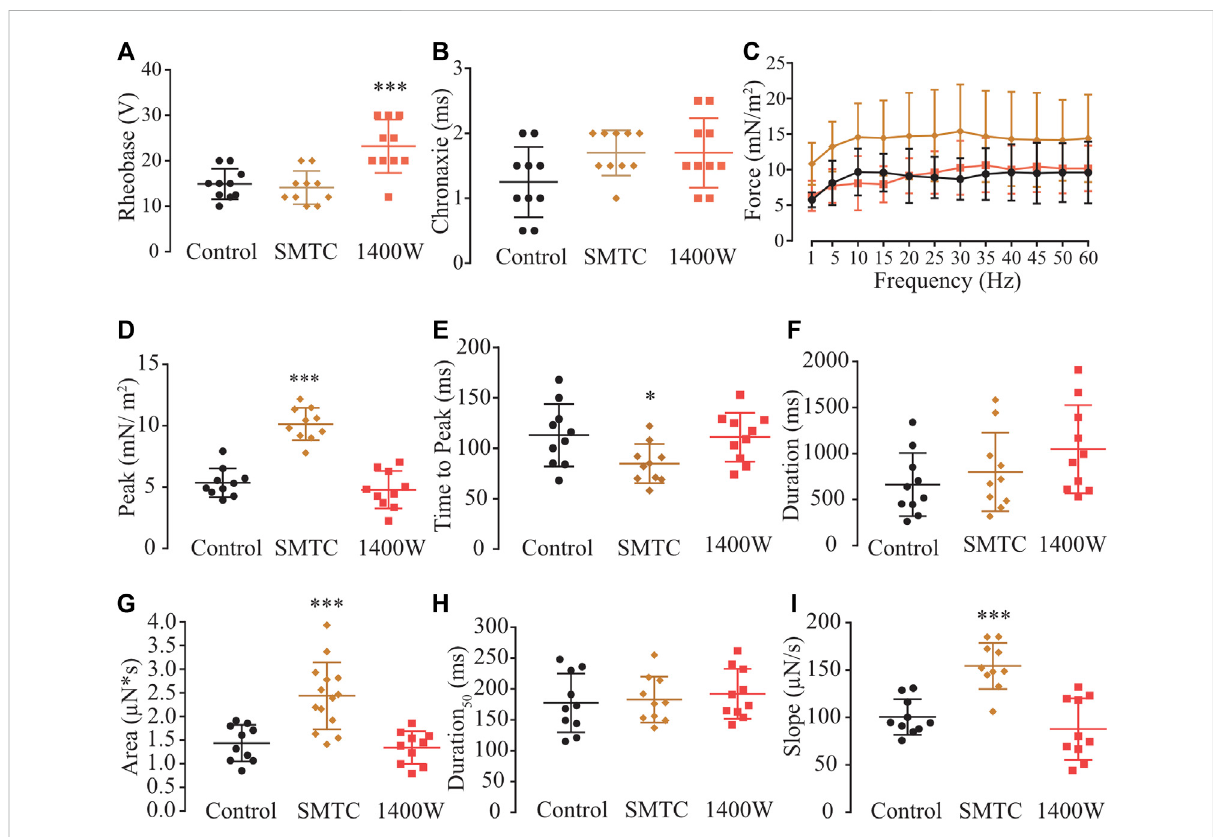
FIGURE 8 Determination of the function of each NOS isoform expressed in the myooid in response to electrical stimulation. Myooids perfused with control solution are represented by the black color, copper for myooidstreated with nNOS blocker SMTC, and coral red for those treated with iNOS blocker 1400 W. (A) . Rheobase and (B) . Chronaxie summarized the excitability of the myooids under subthreshold stimulation. (C) . Force frequency protocol. (D – I) analyses of the biophysical parameters in response to single-twitch stimulation. Each condition contained ten myooids and the symbols *, **, and *** represent the signi fi cant threshold below 5%, 1%, and 0.1%,